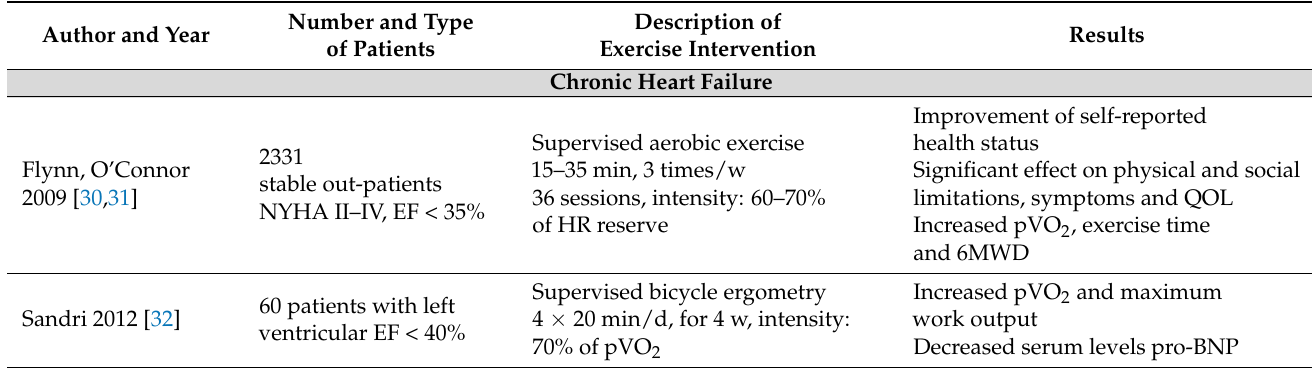
Table 2. Selected studies of exercise in patients with heart failure, preoperative cardiosurgical